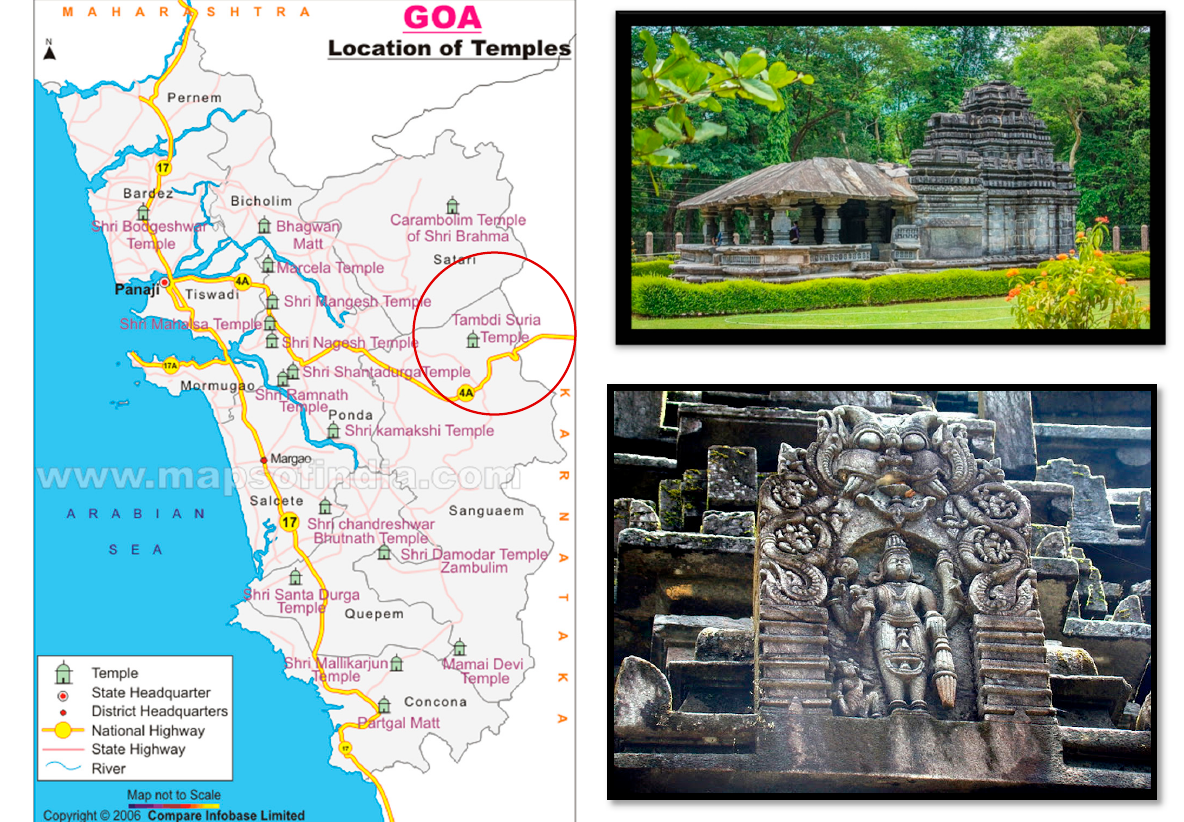
Figure 5. Ś ri Mahadev Temple, Tambdi Suria, Goa, Kadamba dynasty 12th/13th c. Figure 5. ´Sri Mahadev Temple, Tambdi Suria, Goa, Kadamba dynasty 12th/13th